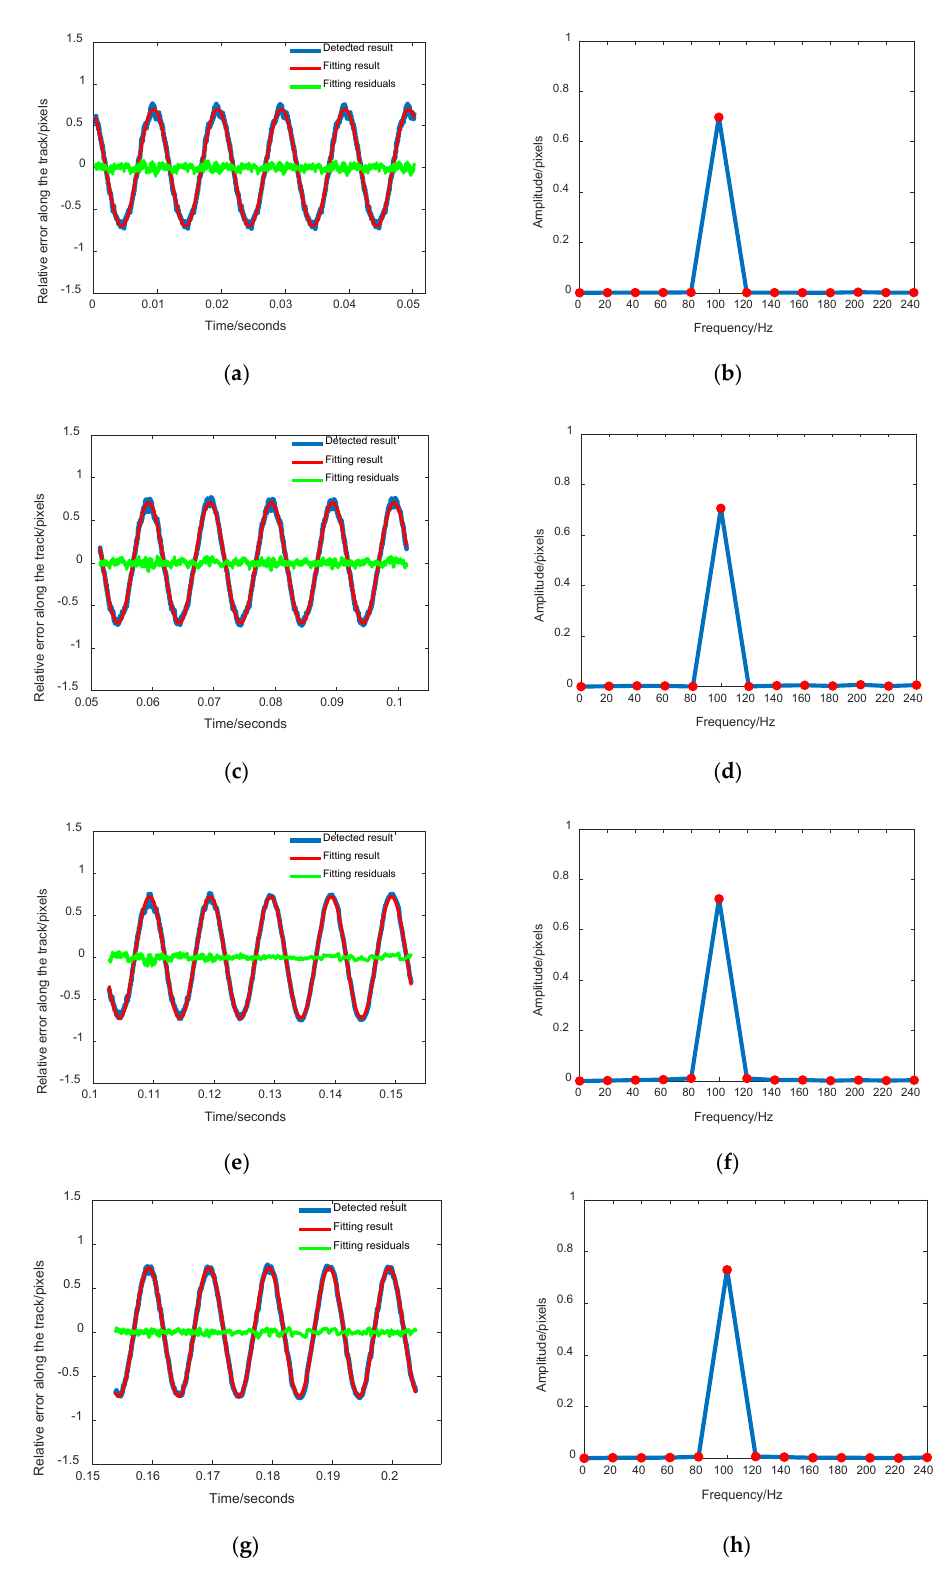
Figure 5. The 100 − Hz Jitter detection curves and Fourier analysis results by single disparity map generated from two adjacent sequence images. ( a ) Jitter detection curve by image 1–2; ( b ) Fourier analysis results of jitter detection curve by image 1–2; ( c ) Jitter detection curve by image 2–3; ( d ) Fourier analysis results of jitter detection curve by image 2–3; ( e ) Jitter detection curve by image 3–4; ( f ) Fourier analysis results of jitter detection curve by image 3–4; ( g ) Jitter detection curve by image 4–5; ( h ) Fourier analysis results of jitter detection curve by image 4–5.